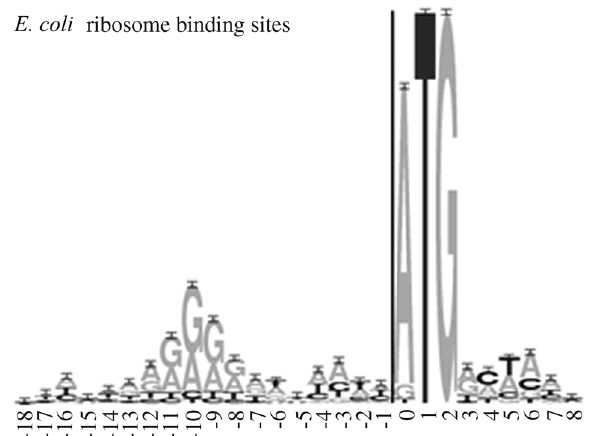
Figure1 -SequenceLogobuiltusing149selectedsequencesofthe E.coli genome. The RBS pattern can be seen between the positions -13 and -6, where there is a high concentration of purine bases. Figure taken from Schneider (1990).